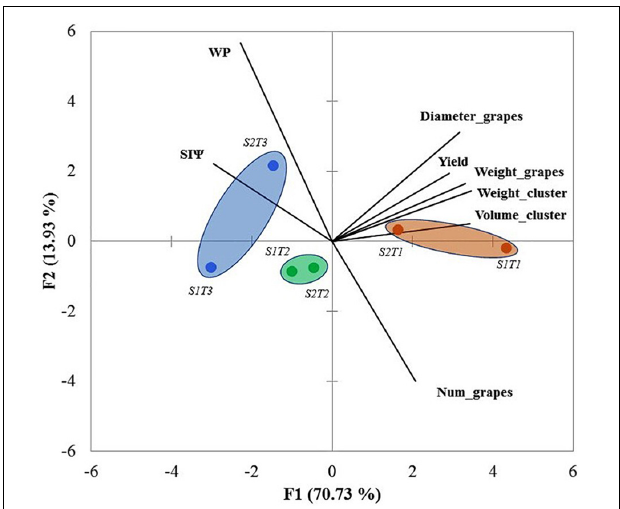
FIGURE 3 | Principal component analysis (PCA) considering all data sets for the growing seasons 2011/2012 and 2012/2013 (cv. Carménère). SI (cid:57) , integral water stress; WP, water productivity; Diameter_grape, diameter of grape; Weight_cluster, weight of cluster; Weight_grape, weight of grape; Volume_cluster, volume of cluster; Num_grapes, number of grapes; S1 = season 2011/12 and S2 = season 2012/13. T1, T2, and T3 are the irrigation